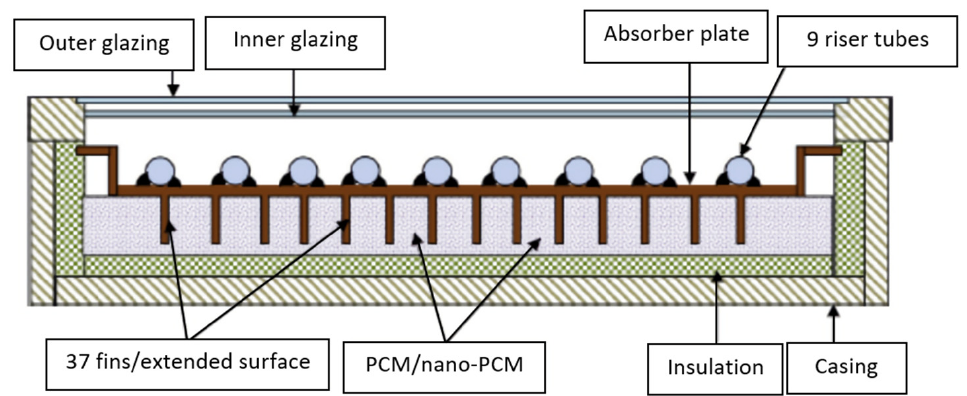
Figure 13. Schematic view of PCM-integrated ETC. Adapted with permission from ref. [128] 2014 Al-Kayiem and Lin.